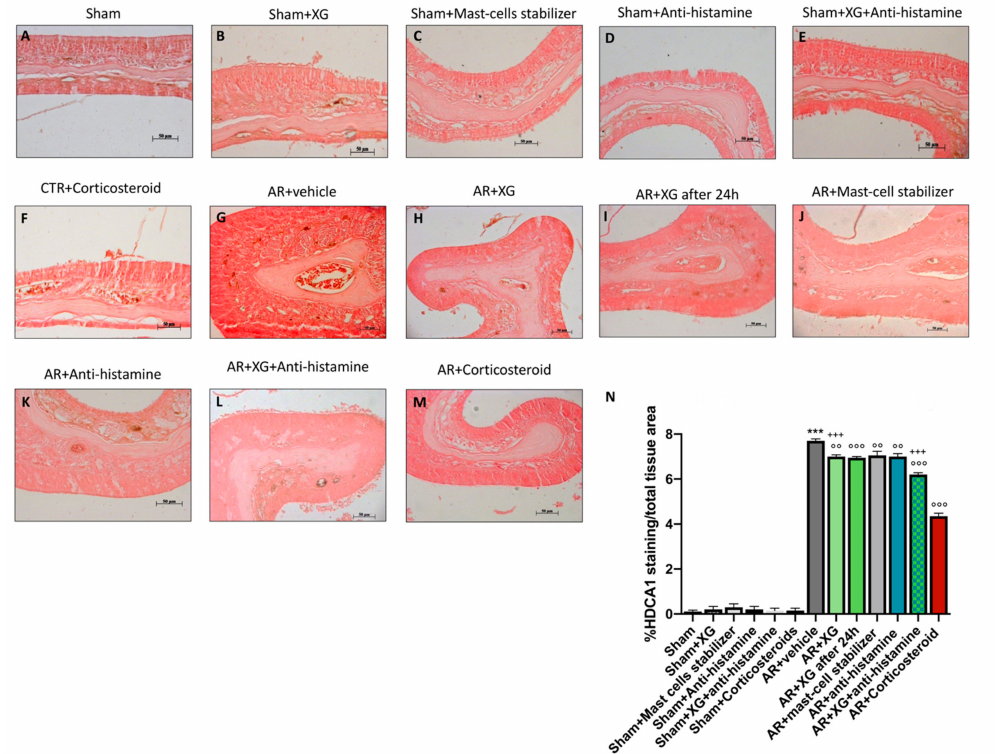
Figure 8. Effect of XG treatment on HDAC1 expression. OVA-challenged nasal mucosa exposed an evident increase of HDAC1 expression ( G , histological score N ) compared to the sham groups ( A – F , histological score N ); Single treatments with XG-based spray significantly reduced HDAC1 expression ( H , I , histological score N ) similarly to antihistamine ( K , histological score N ) and mast cell stabilizer ( J , histological score N ) administrations. Co-treatment consisting of XG and antihistamine proved to be efficacious in decrease HDAC1 levels ( L , histological score N ), analogously to treatment with corticosteroid ( M , histological score N ). Data are representative of at least three independent experiments. Values are means ± SEM. One-Way ANOVA test. *** p < 0.001 vs. Sham; ◦◦ p < 0.01 vs. AR + vehicle; ◦◦◦ p < 0.001 vs. AR + vehicle; +++ p 0.001 vs. AR +